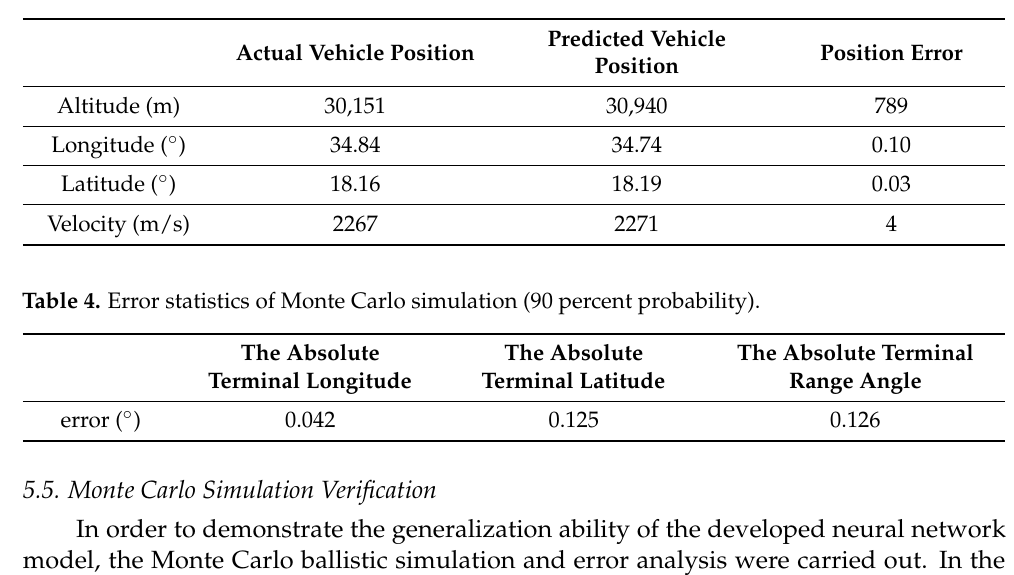
Figure 11. Inclination angle error change with time. Table 3. Error statistics.